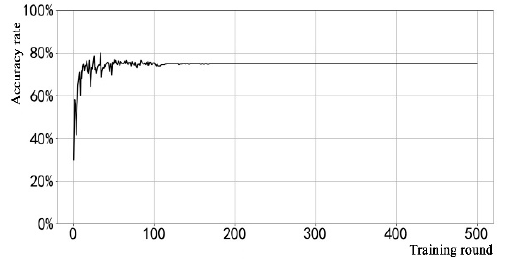
Figure 33. Accuracy of 50% expert-driven learning.